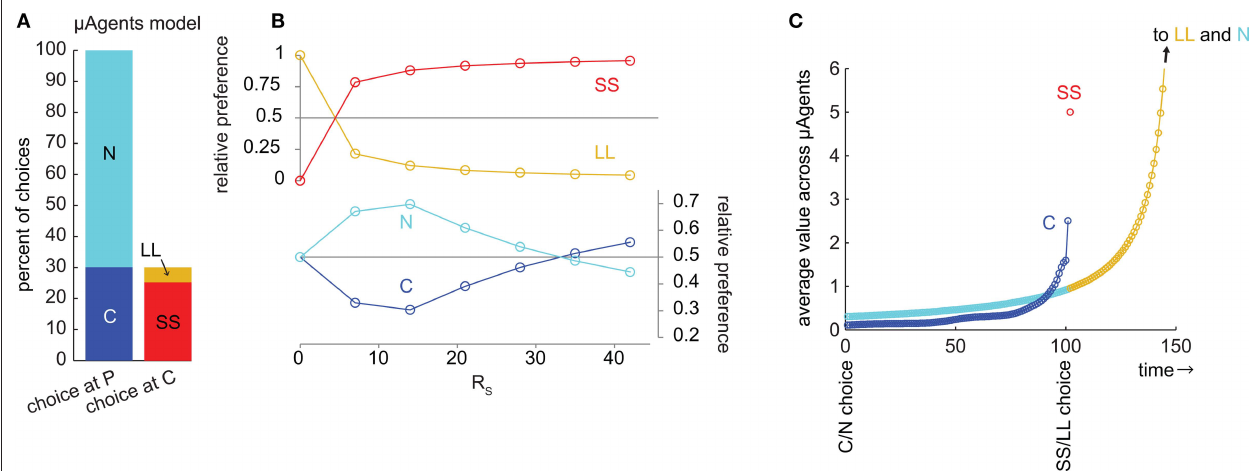
average value of each option over time. The distributed value representation Figure 2 | The μAgents model exhibited precommitment behavior. of μAgents allowed average values to cross. The value of C prior to (A) From P, the model chose N more often than C. However, when C was discounting across the D interval was between the discounted values of SS reached, the model chose SS more often than LL. This bar graph represents C and LL, and was therefore above N. However, during the D interval, the value the same data as (B) at R = 10. (B) plots the same information as (A) , over a C S of C crossed under N, such that N > C at the time of the C/N choice. Note that range of values of R . For very small R , LL > SS and N > C. For very large R , S S S (C) uses a fully Markov state-space to show how values are discounted SS > LL, and C > N. However, precommitment could occur because SS through each intermediate time point. Each circle shows the value of one crossed LL at a different point than C crossed N, meaning that there was a state after values are fully range of R for which SS > LL and N > C. (C) illustrates the change in the S